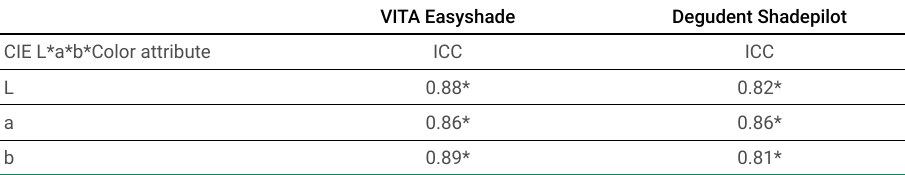
Table 4. Intra device reliability of the color coordinates VITA Easyshade Degudent